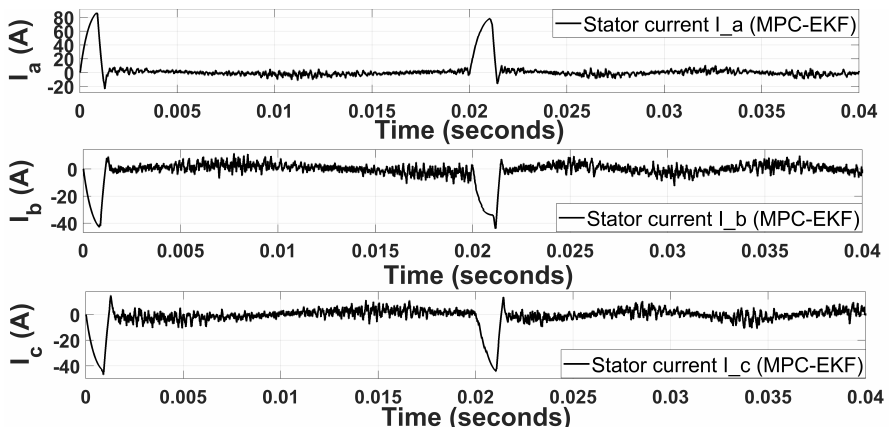
Figure 10. Three-phase stator currents for